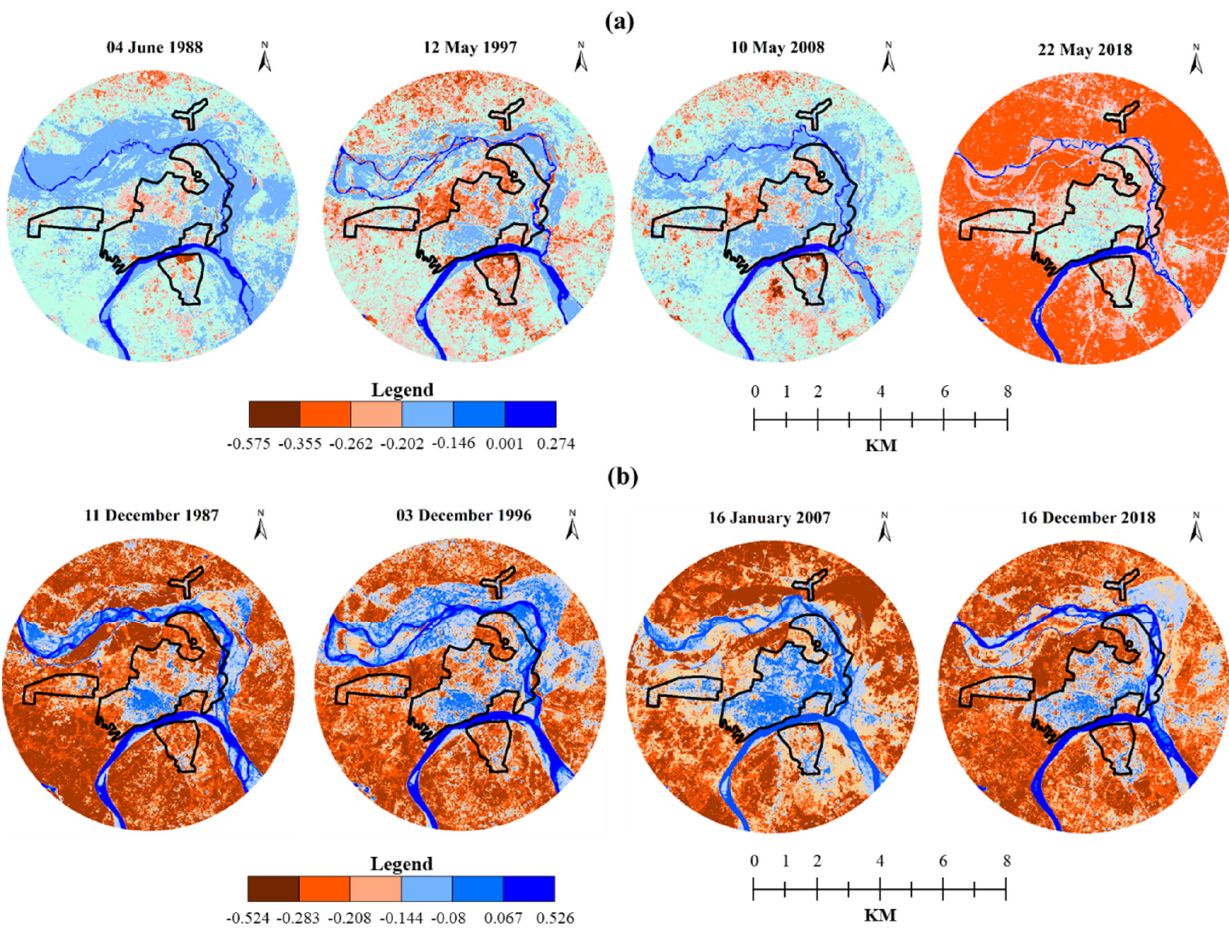
Figure 11. Seasonal NDWI dynamics in Prayagraj city (1987–2018): ( a ) summer and ( b ) winter. High-density water bodies were concentrated in the northeast (8–9.5 km) due to the Ganga River flow in S1 and W1. The high-density vegetation was concentrated in the northwest and southeast, which decreased in S2, W2, S3, and W3. Then, high-density vegetation increased in the northwest and southeast in S4 and W4, respectively. Therefore, it is apparent that the forest and grassland were mainly dominant in the northwest direction from the city